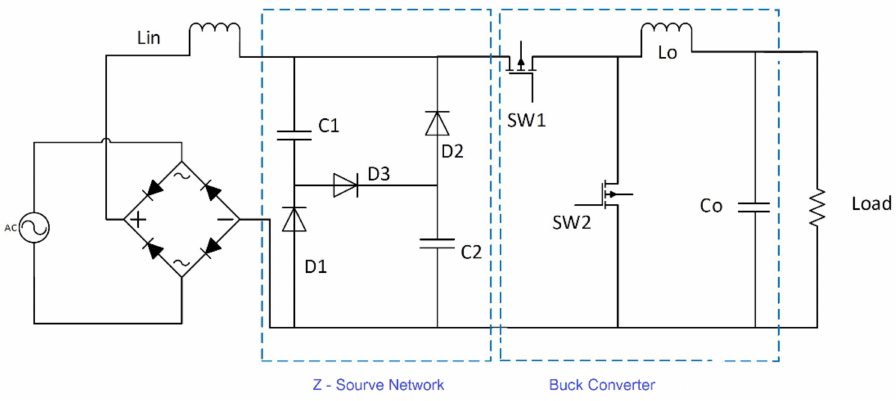
Figure 2. The Z source buck